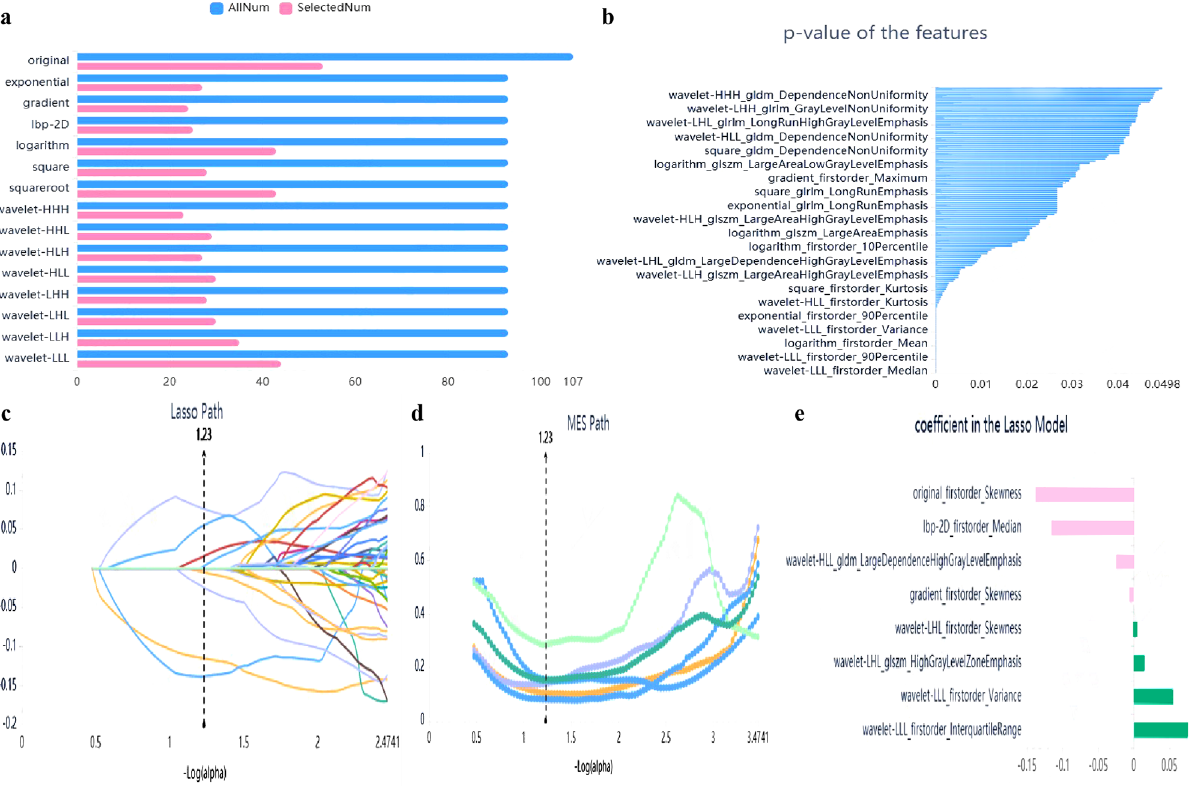
Figure 3. Dimension reduction analysis and feature selection for T 2 WI. ( a ) Variance threshold method was used to select 486 features from 1409 radiomics features (variance threshold = 0.8); ( b ) 145 feat ures were retained using select K best ( P value < 0.05); ( c – e ) 145 features were retained using LASSO algorithm method. Eight eigenvalues were